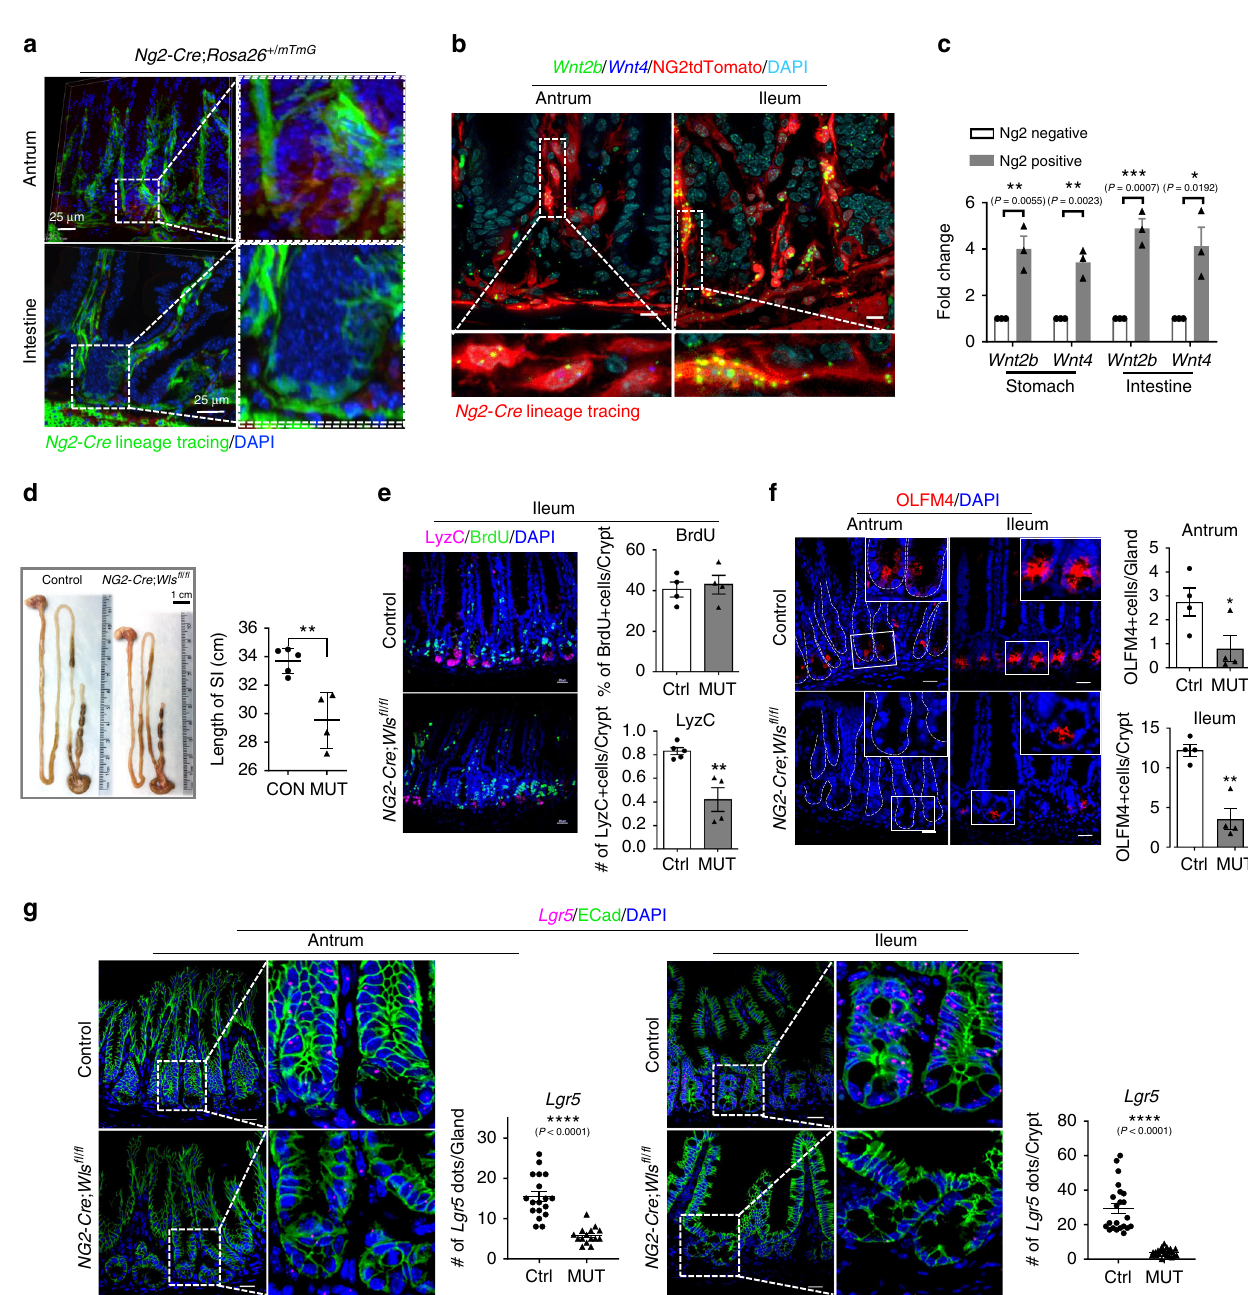
Fig. 3 Wnt secretion from pericyte-like stromal cells is required for adult stem cells homeostasis. a 3D images of pericyte-like stromal cells surrounding gastrointestinal epithelial cells are visualized by lineage tracing in Ng2-Cre ; Rosa26 + /mTmG mice. b smFISH in Ng2-Cre ; Rosa26 + /tdTomato mice shows the expression of Wnt2b (green puncta) and Wnt4 (blue puncta) in gastrointestinal pericyte-like stromal cells (tdTomato-red). c Quantitative RT-PCRs shows signi fi cantly increased levels of Wnt2b and Wnt4 expression in Ng2-tdTomato positive stomach and intestinal stromal cells compared to Ng2-tdTomato negative cells ( n = 3 per group). d The intestinal length is signi fi cantly reduced in Ng2-Cre ; Wls fl / fl mice compared to the controls ( n = 5 per group). e Immuno fl uorescence staining (IF) of BrdU and Lysozyme C (a Paneth cell marker) shows no defects in intestinal proliferation but a mildly decreased number of Paneth cells in Ng2-Cre ; Wls fl / fl mice compared to the controls ( n = 4 per group). f IF of OLFM4 in antrum and ileum shows signi fi cantly decreased numbers of OLFM4 + gastrointestinal stem cells in in Ng2-Cre ; Wls fl / fl mice compared to the controls ( n = 4 per group). Scale bars indicate 20 μ m. g smFISH of Lgr5 in the antrum and ileum. Magenta dots indicate Lgr5 transcripts. The number of Lgr5 transcripts was signi fi cantly reduced in Ng2- Cre ; Wls fl / fl mice compared to the controls. Scale bars indicate 20 μ m. *P < 0.05, * *P < 0.01, *** P < 0.001, **** P < 0.0001. P values were determined using nonparametric unpaired Student ’ s t test. Values are mean ± SEM. Each n means biologically independent animals and